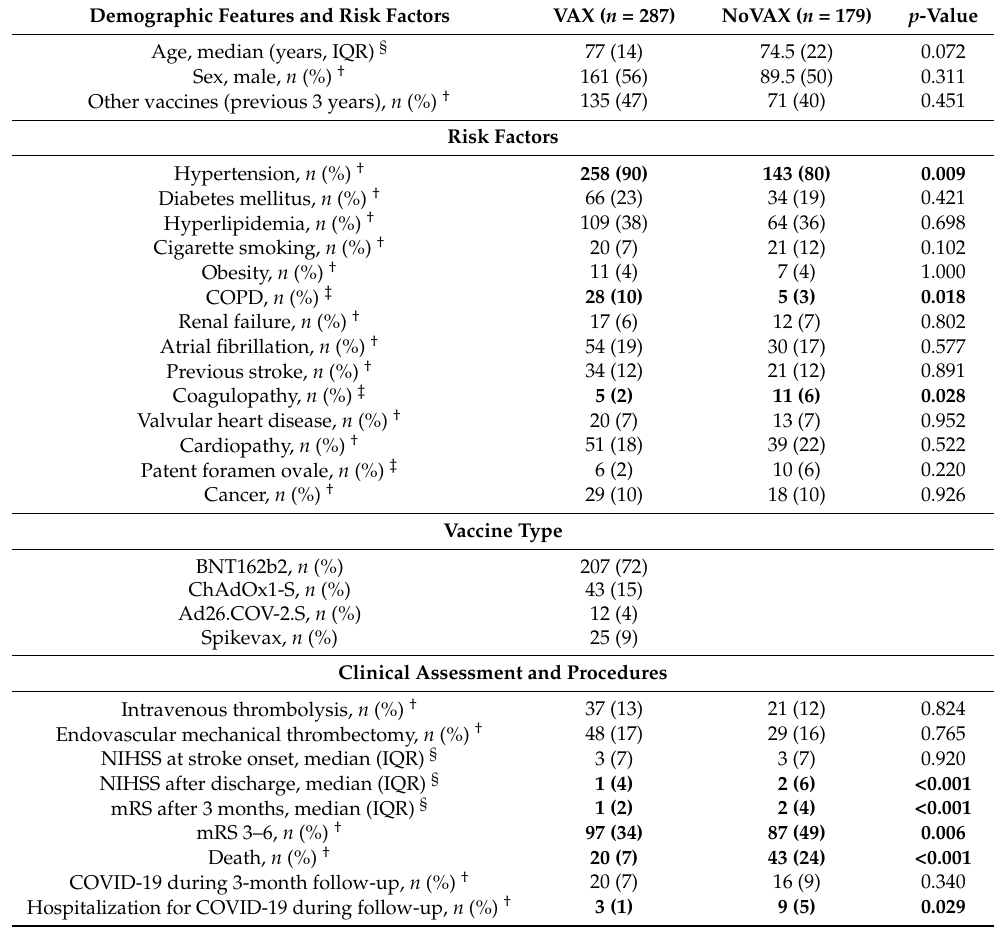
Table 1. Demographic and clinical features of VAX and NoVAX